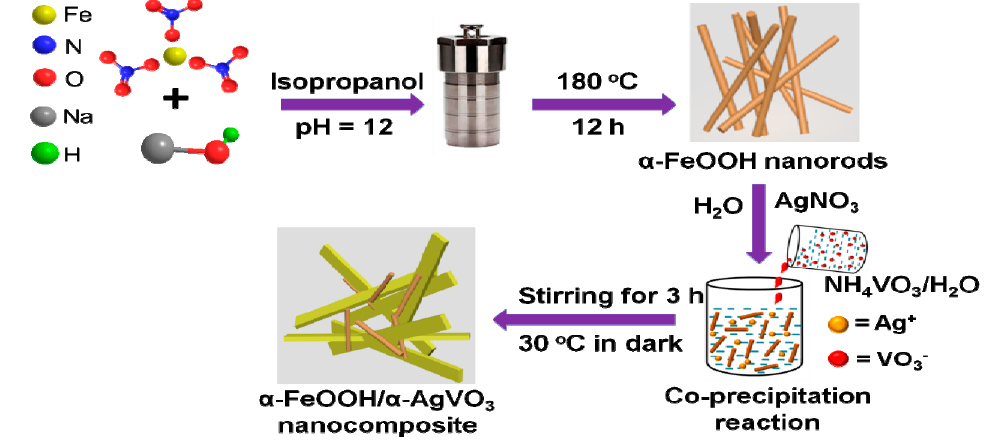
Figure 1. A schematic representation of the synthesis route of α -FeOOH/ α -AgVO 3 nanocomposite photocatalyst.